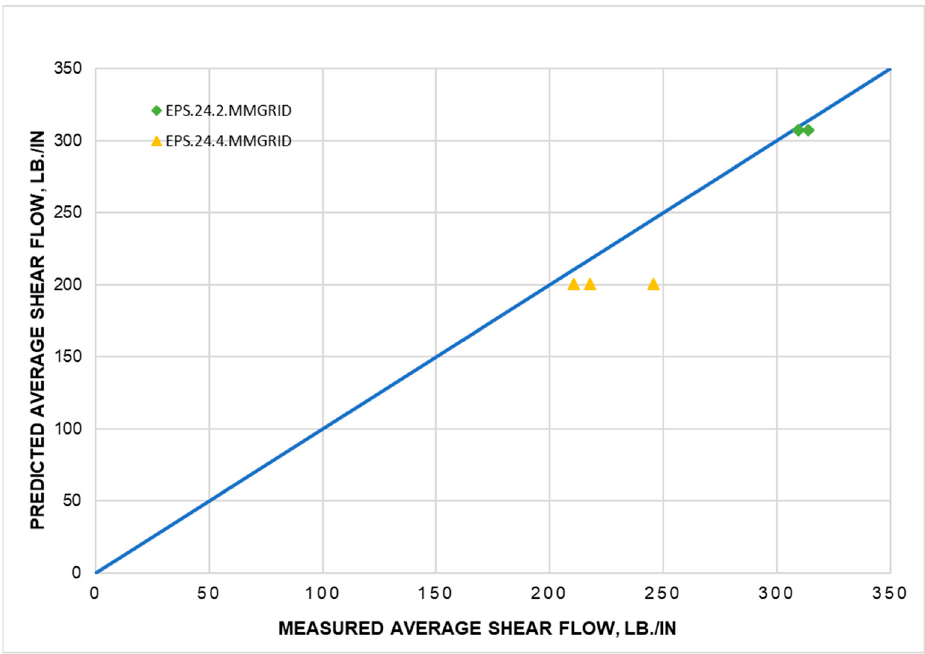
Figure 25. Predicted values from the Choi et al. equation [17] based on a 80% con fi dence interval vs. measured average shear fl ow (1 lb/in = 0.2 N/mm).